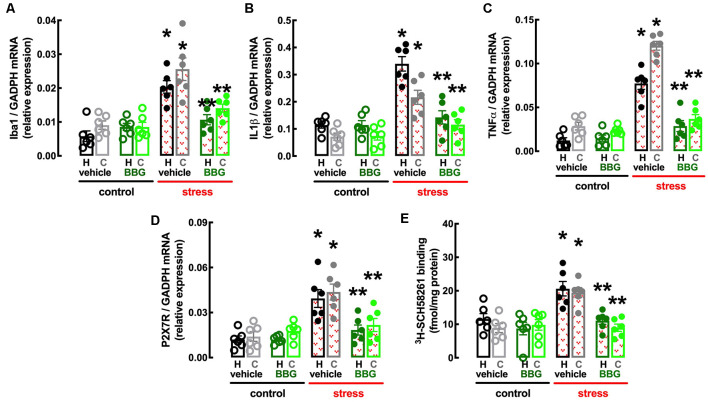
Male adult Wistar rats (8–10 weeks old) subject to a protocol of restraint stress (4 h/day) during 14 days display an increased expression of inflammatory markers and an up-regulation of P2X7 and A2A receptors in the hippocampus (black, dark green) and prefrontal cortex (gray, light green) which were prevented by the P2X7 receptor antagonist Brillant Blue G (BBG). Whereas BBG treatment (45 mg/kg, ip, daily, beginning 3 days before the stress protocol and until the sacrifice of the animals; green) was devoid of effects in non-stressed control rats (open bars), BBG prevented all alterations of stressed rats (red checkered bars), namely the increased expression of the microglia marker Iba1 (A), of interleukin 1β (IL1β; B), of tumor necrosis factor α (TNFα; C), and P2X7 receptors (P2X7R; D) as well as an increased density of A2A receptors (A2AR; E) as assessed by the binding density of a supramaximal concentration of the selective A2AR antagonist 3H-SCH58261 (2 nM). Data are shown as mean ± SEM; n = 5–7 rats per group. *P < 0.05 vs. control-water, **P < 0.05 vs. stress-water using a Tukey’s multiple comparisons post hoc test after a two-way ANOVA.